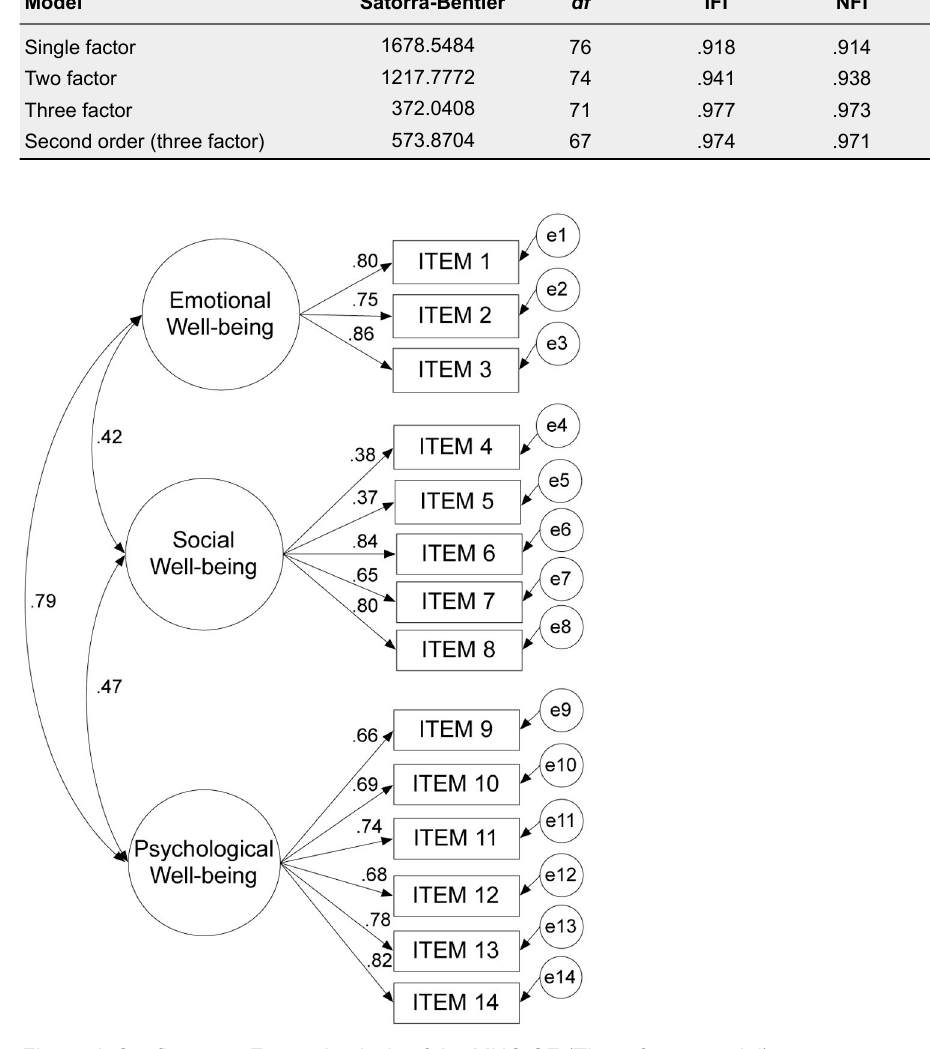
Figure 1. Confirmatory Factor Analysis of the MHC-SF (Three factor